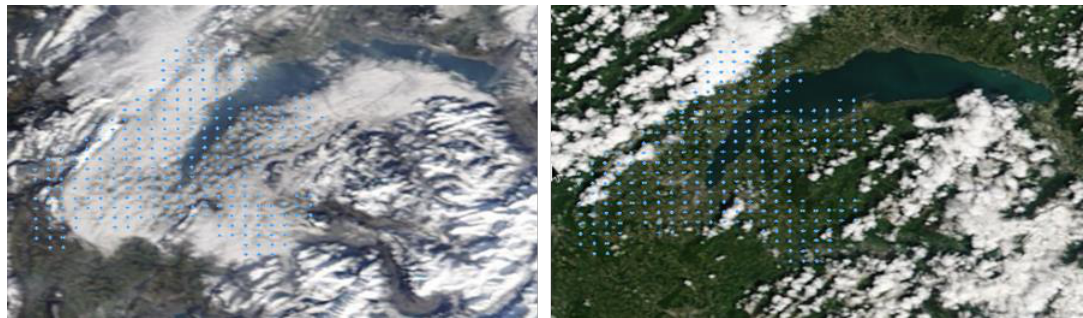
Figure A1. Typical stratus during winter ( left ), typical cumulus coverage above mountain summits during summer ( right ); the dot points representing the center of the tiles (credit: https://worldview.earthdata.nasa.gov/).